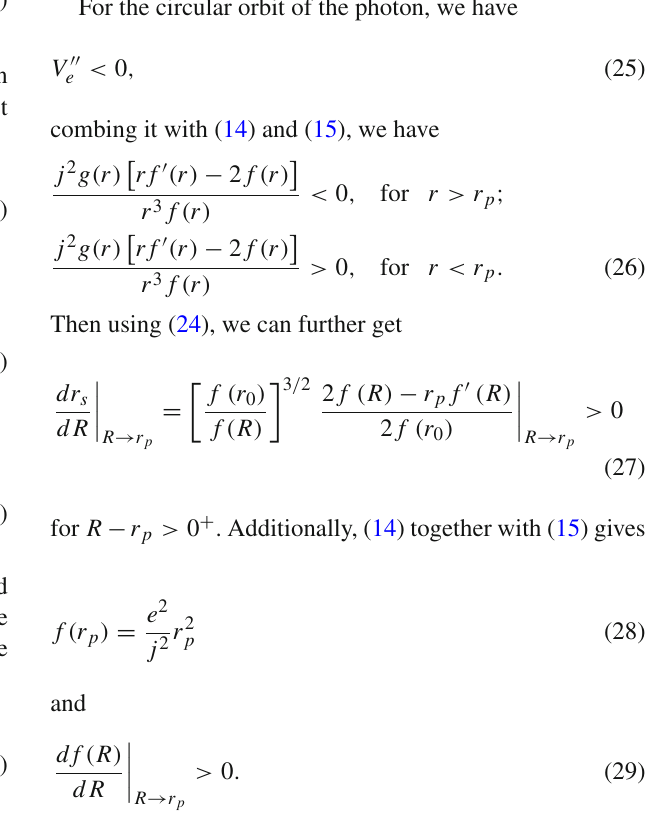
For the circular orbit of the photon, we